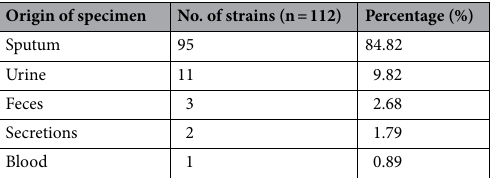
Table 1. Origins of specimens from patients with suspected bacterial infection.